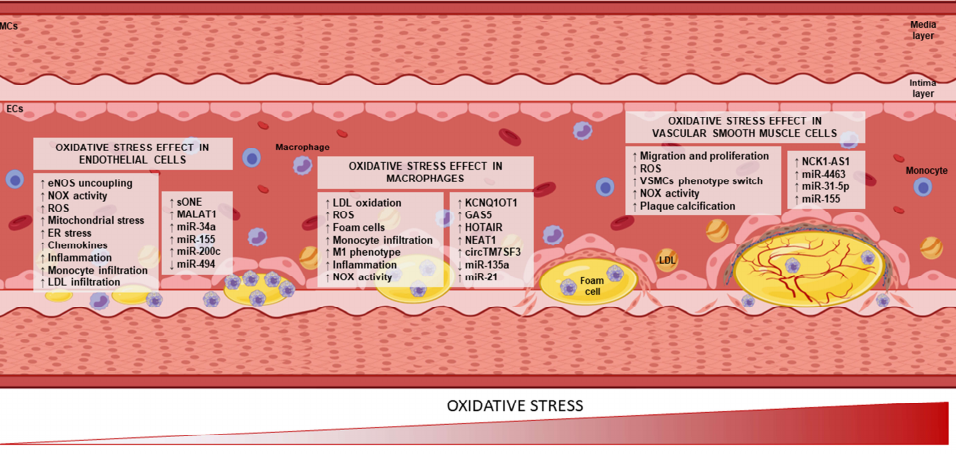
Figure 2. Roles ncRNAs and OxS play in atherosclerotic progression. The OxS effect in endothelial cells, macrophages, and vascular smooth muscle cells at a molecular scale and the regulation of different types of ncRNAs, such as sONE, GAS5, or miR-4463, respectively, are represented in this graphic. eNOS: endothelial nitric oxide synthase, NOXs: NADPH oxidases, ROS: reactive oxygen species, ER: endoplasmic reticulum, LDL: low-density lipoprotein, M1: type-1 macrophages, VSMCs: vascular smooth muscle cells. ↑ up regulation, ↓ down regulation.